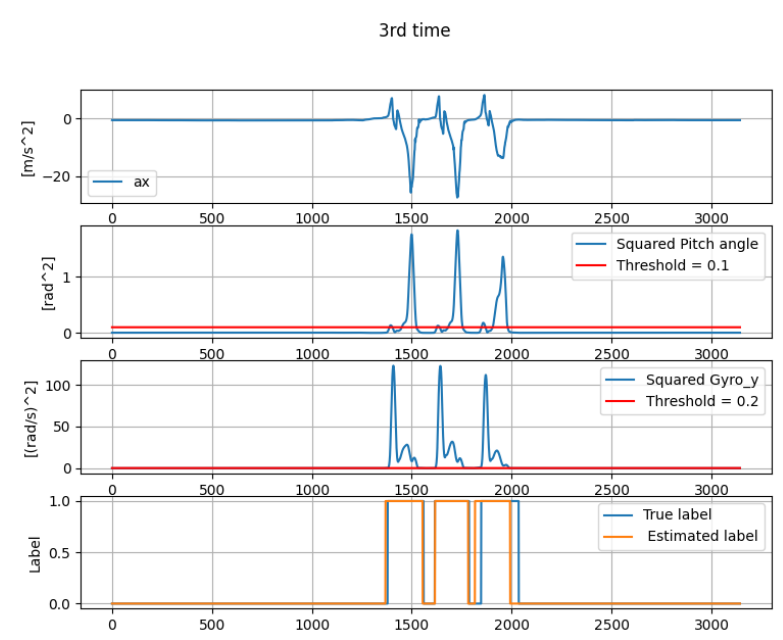
Figure 12. The wave-form of the data from the third data